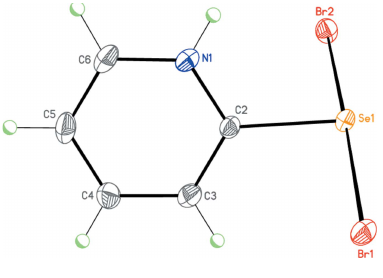
Figure 5 Molecular structure of 1 . Displacement ellipsoids are shown at the 50% probability level. H atoms are presented as small spheres of arbitrary radius.